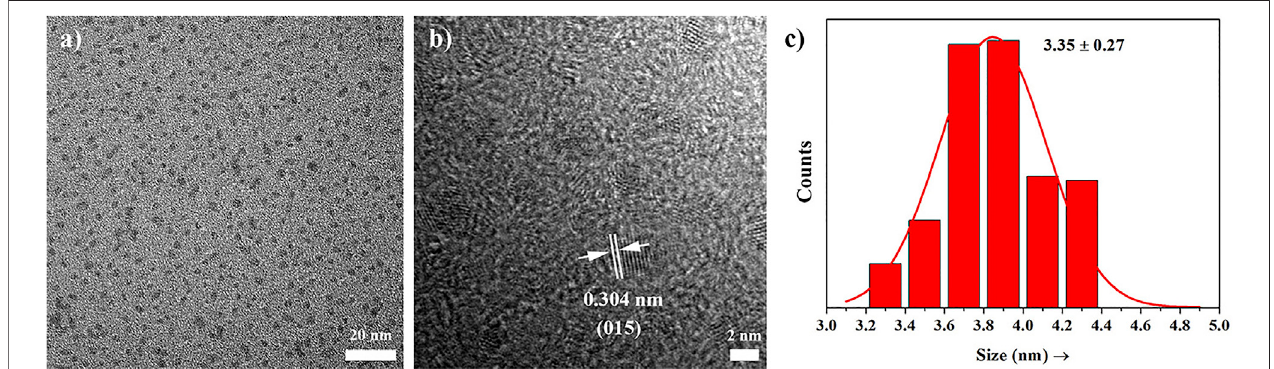
FIGURE 1 | (A) TEM image, (B) HRTEM image, and (C) size histogram of PEI-Bi 2 Se 3 nanodots.